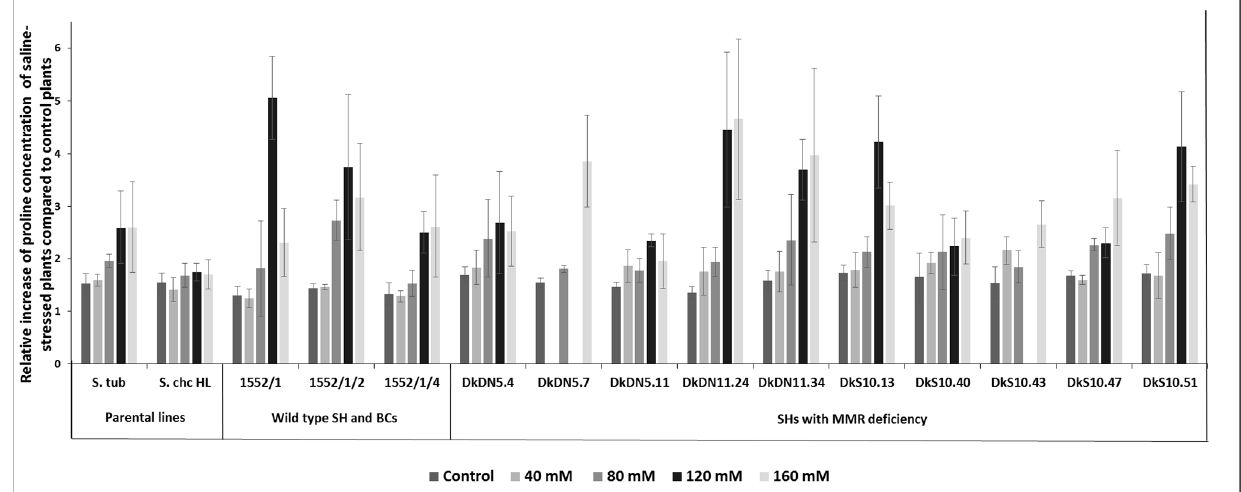
Figure 7. Relative proline concentration changes (mean ± SE, n = 5) during severe salt stress of different SHs with or without MMR deficiency, BC progenies, and parental lines ( S. tuberosum and S. chacoense — S.chc HL).